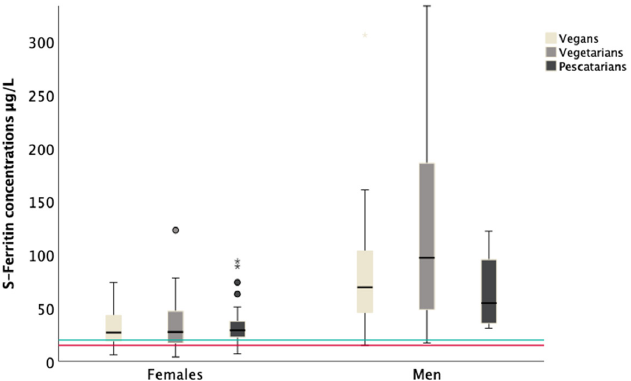
Figure 1. S-Fe concentration ( µ g/L) is presented according to gender and dietary practice. Vegan females ( n = 66), vegetarian females ( n = 42), pescatarian females ( n = 27), vegan men ( n = 40), vegetarian men ( n = 12), pescatarian men ( n = 4). Box plot details are as follows: the horizontal black lines indicate the median, the boxes indicate the interquartile range (IQR) (25th percentile to 75th percentile), the whiskers represent observations within 1.5 times the IQR. Outliers 1.5 times away from the IQR are marked as circles. Extreme outliers are marked as stars, and extreme outliers above 350 µ g/L are excluded from the figure. The marked red line shows the cut-off for iron deficiency in females (<15 µ g/L), the marked green line shows the cut- off for iron deficiency in men (<20 µ g/L). The cut-offs used are based on recommended S-Fe levels by Fürst (Norwegian laboratory).